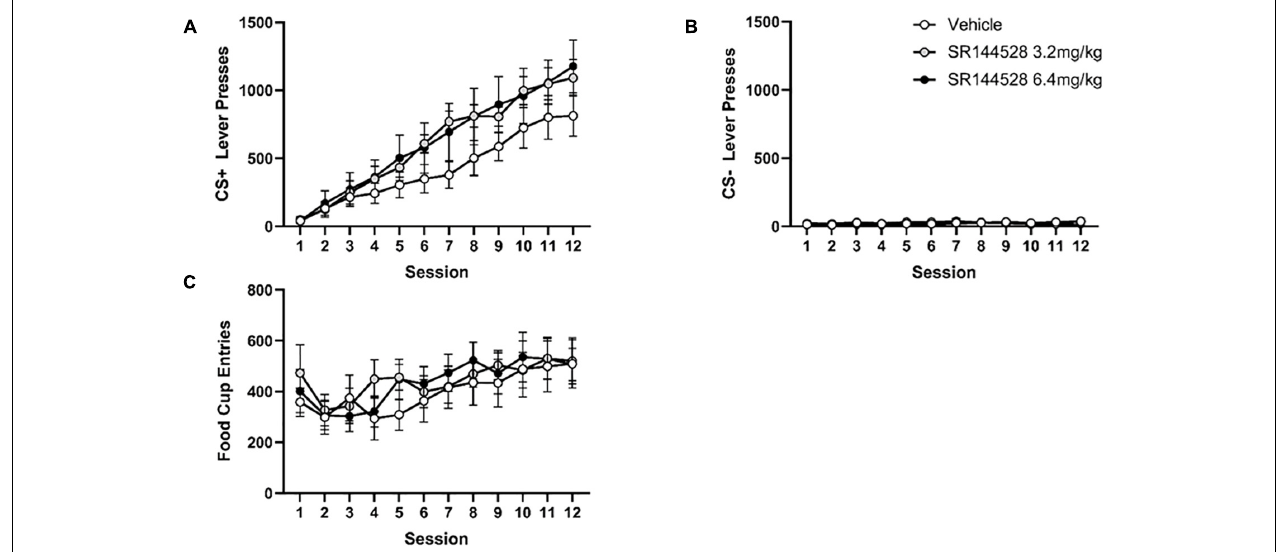
FIGURE 2 | Antagonism/inverse agonism of CB2R during adolescence does not impact instrumental learning in adulthood. (A) Mean CS+ lever presses. (B) Mean CS– lever presses. (C) Mean cumulative food cup entries. Data presented as mean ± SEM.